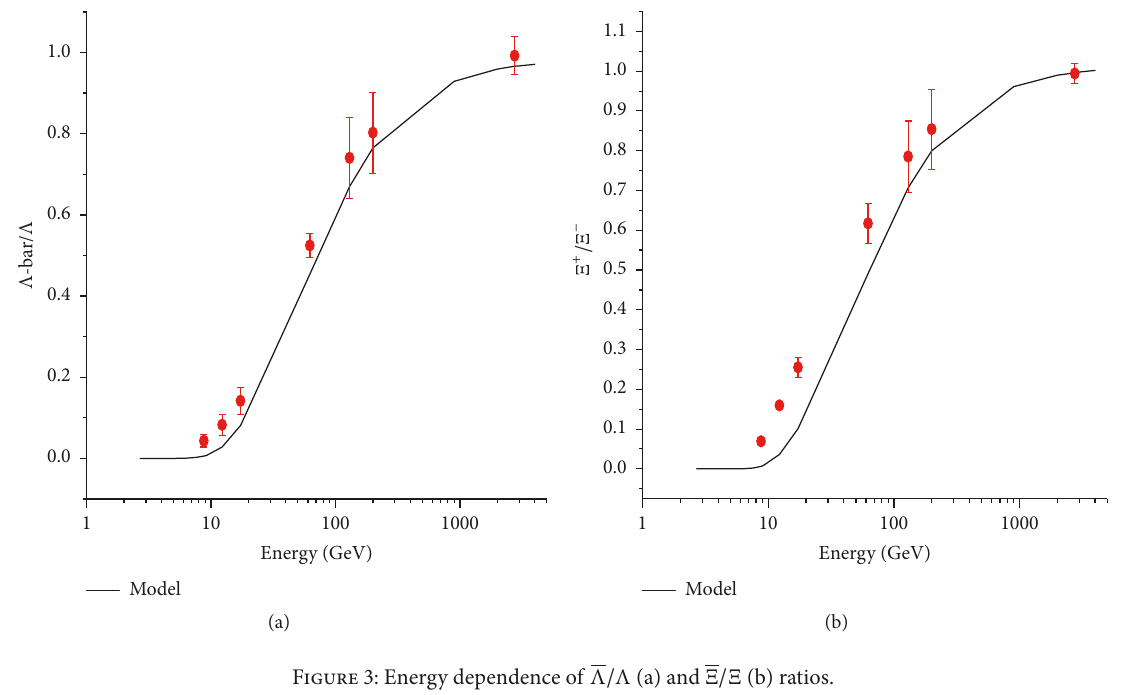
Figure 3: Energy dependence of Λ/Λ (a) and Ξ/Ξ (b) ratios.